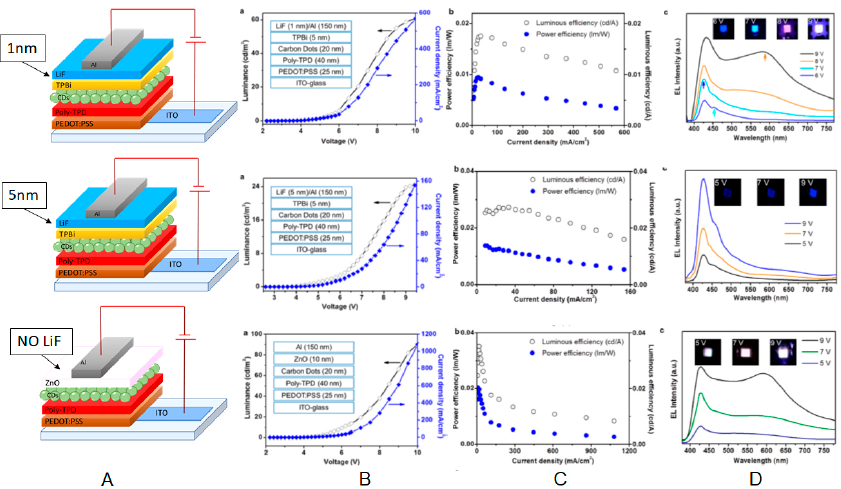
Figure 12. ( A ) Schematic representation of the CD-LED architectures together with ( B ) J and L versus V, ( C ) η c and power efficiencies vs. J, and ( D ) EL spectra and images of the operating CD-LEDs at different applied voltage: Reproduced with permission from [73], copyright 2013 American Chemical Society.